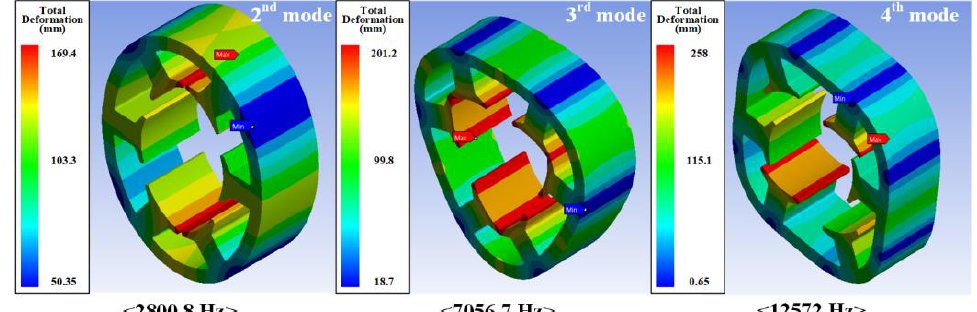
Figure 9. Stator modal analysis results: 2nd mode, 3rd mode, 4th mode.